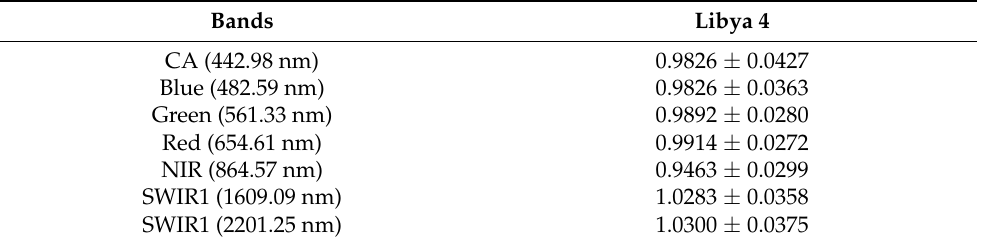
Table 4. Mean K-scale Factors derived from Landsat 8/Hyperion near coincident scene pairs 6 days